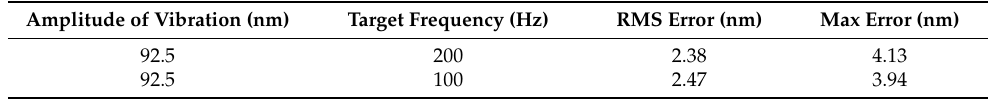
Table 1. Maximum and RMS errors for HD